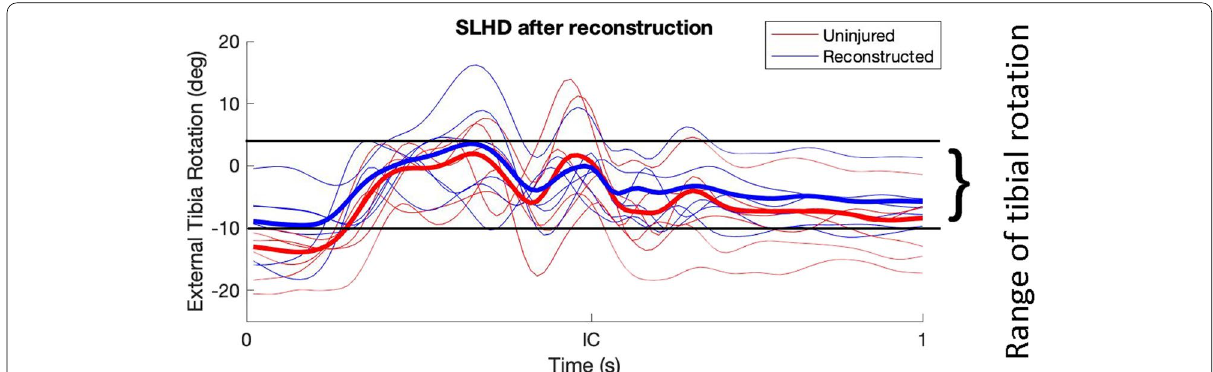
Fig. 1 Example of results regarding the range of tibial rotation in both ACL injured knees (red lines) and ACL reconstructed knees (blue lines). The averages are depicted using the bold red and blue line respectively, The solid black lines represent the upper and lower limit of the range of rotation, in this example from the ACL injured knees